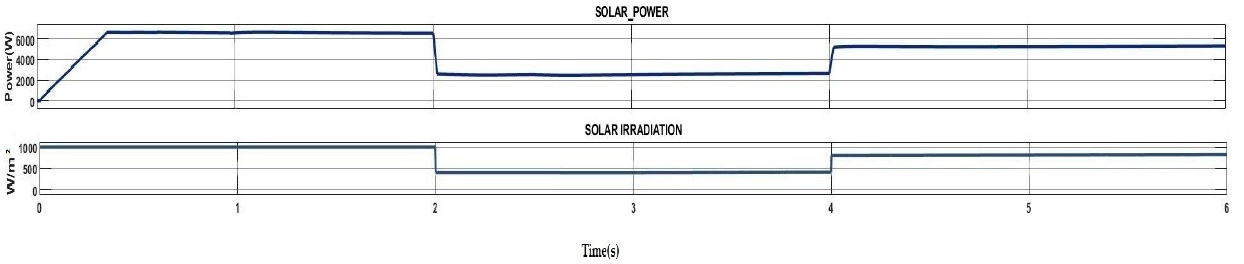
Figure 5. The output power of the PV system.